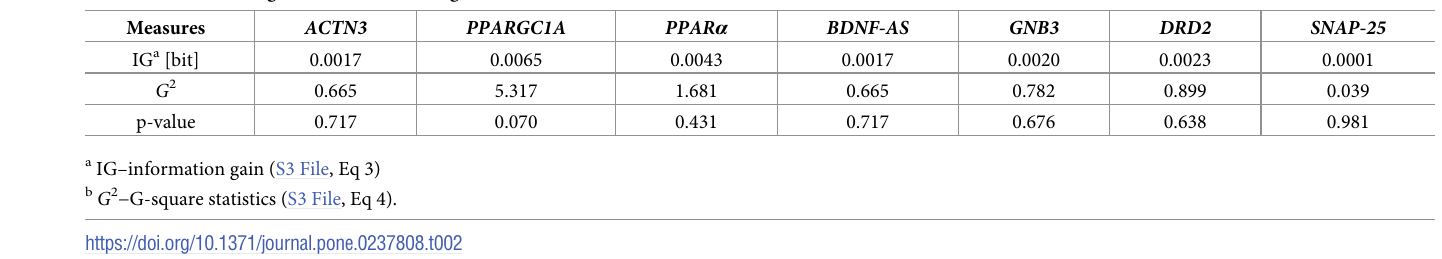
Table 2. Information gain values of studied genetic